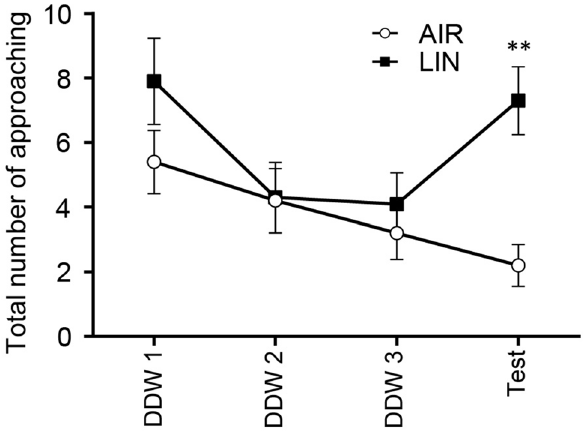
Figure 6. Olfactory habituation/dishabituation test confirmed the ability to detect the linalool odor under intrathecal administration of an orexin 1 receptor antagonist. Each dot represents the number of approaching to the cotton swab. DDW1, DDW2, DDW3: First, second, and third exposure to cotton swab soaked in 20 μL of double distilled water (DDW); Test: exposure to a swab soaked in 20 μL of linalool (linalool group) or with 20 μL of DDW (control group). n = 10 for both groups. Values are represented as mean ± SEM. ** p < 0.005 between control and linalool odor-exposed group in the Test session (Sidak’s multiple comparison